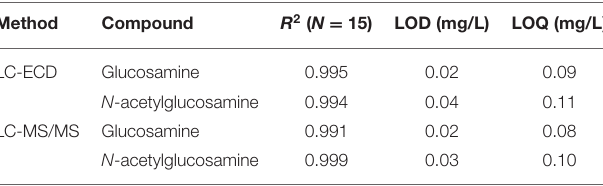
TABLE 2 | Linearity (expressed as coefficient of determinations, R 2 ), limit of detection (signal-to-noise ratio of 3) and limit of quantification (signal-to-noise ratio of 10) of glucosamine and N -acetylglucosamine as assessed by LC-ECD and LC-MS/MS.